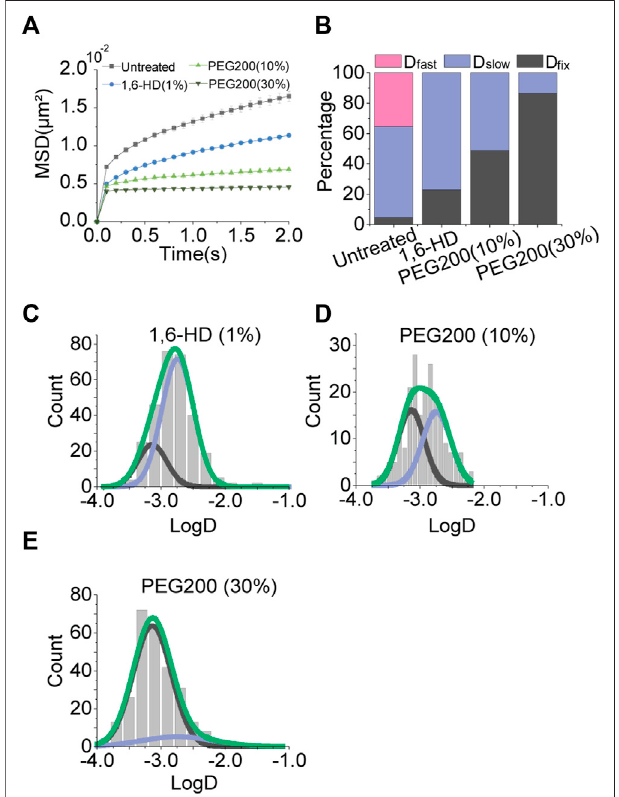
FIGURE 4 | Effects of osmotic pressure. (A) Averaged MSD-t plots for each time interval underthenormalconditionand osmotic pressures(1% 1,6- hexanediol, N = 31 cells, n = 314 trajectories; 10% PEG200, N = 20 cells, n = 231 trajectories; 30% PEG200, N = 20 cells, n = 302 trajectories). (B) Percentages of diffusion constant components from multimodal Gaussian fi ttings for each condition. (C – E) Distributions of diffusion constants for individual trajectories in cells treated with 1% 1,6-hexanediol, 10% PEG200, and 30% PEG200, respectively. Green lines represent fi tting with triple Gaussian peaks for the entire distribution. Blue and black lines represent single Gaussian portions for slow and fi xed diffusions, respectively.